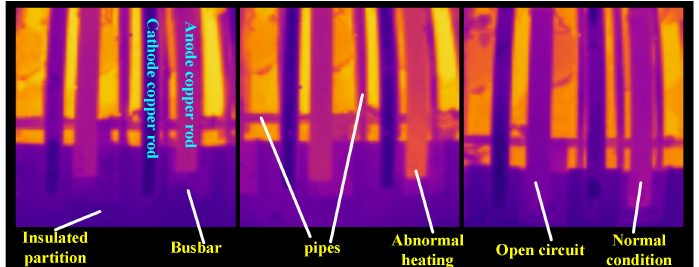
Figure 4. Infrared images of copper rods under different conductive states.